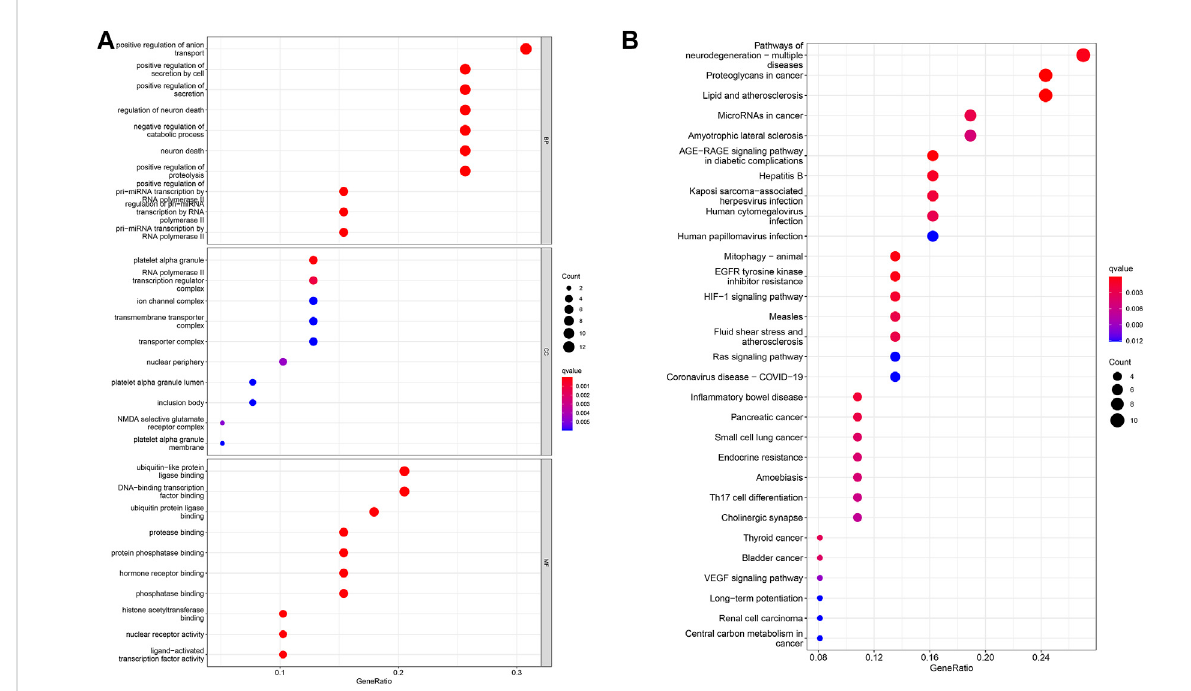
FIGURE 3 Analysis of DEG distribution and function in LUAD patients. (A) GO enrichment analysis of biological process (BP), cellular component (CC) and molecular function (MF) results ranked by the adjusted p -value. (B) KEGG enrichment analysis results showed that DEGs were strongly associated with the AGE-RAGE signaling pathway and EGFR tyrosine kinase inhibitor resistance